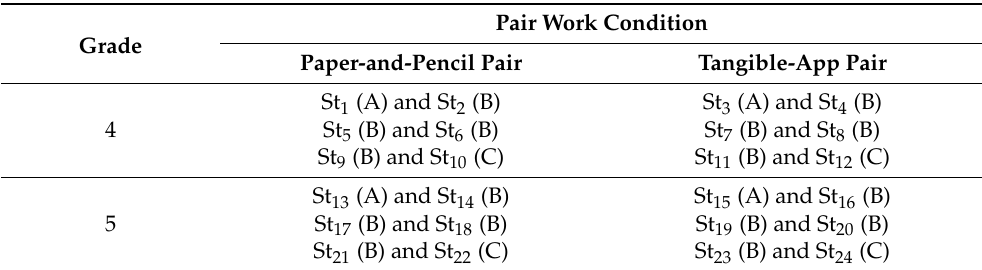
Table 1. Participating student ( N = 24) pairs by grade, mathematics attainment level, and pair work